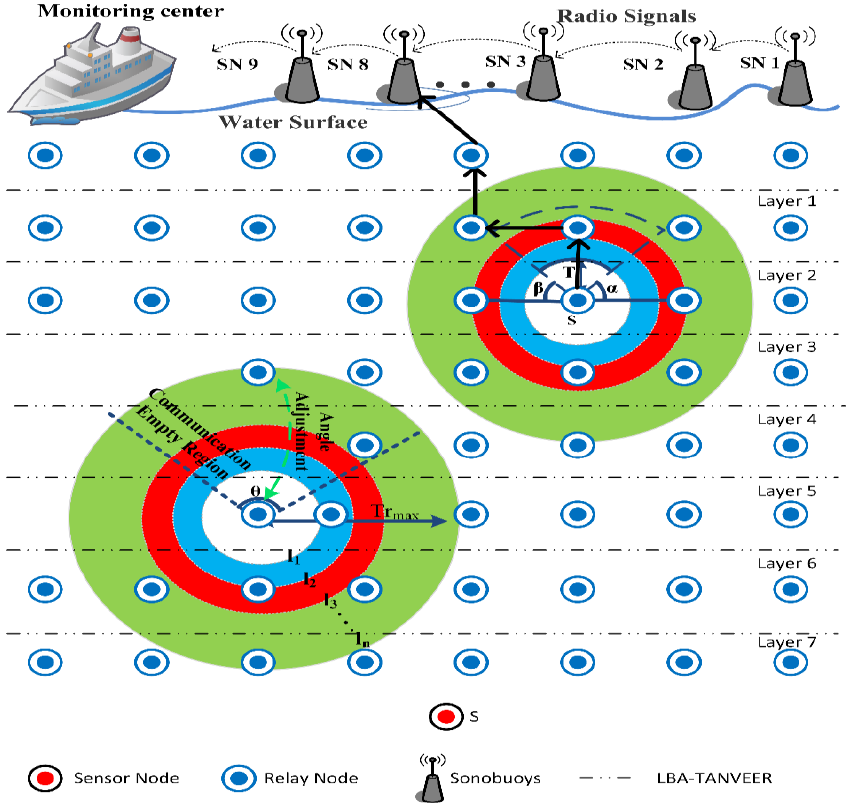
Figure 3. Layers-Based Adjustment (LBA) to ordinary nodes.